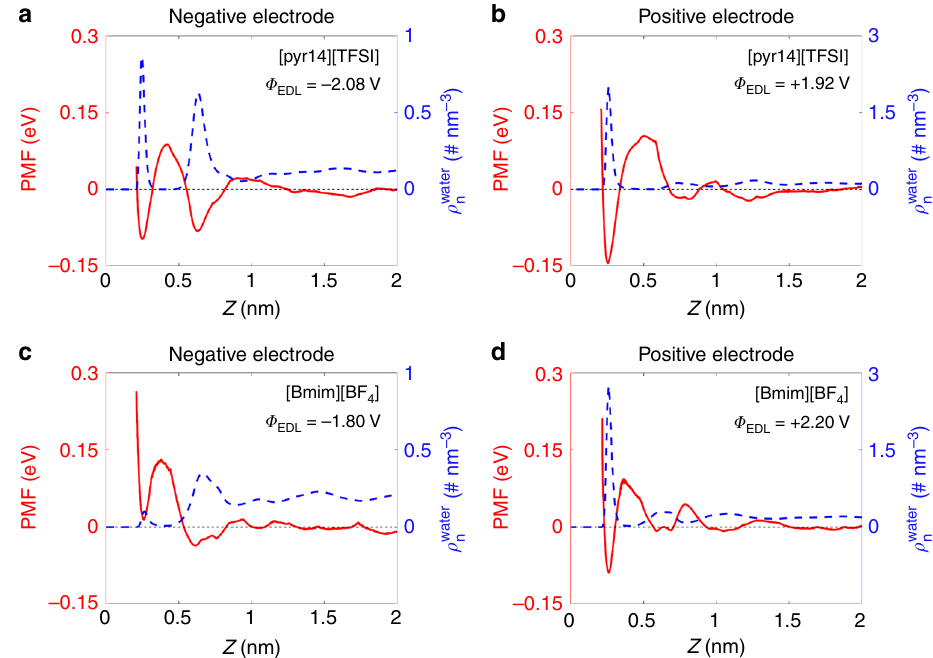
Fig. 4 The propensity for water electrosorption at gold electrodes. a – d Correlation between the distributions of water density (dashed blue lines, right blue y -axis) and the potential of mean force (PMF) for water (solid red lines, left red y -axis) for room temperature ionic liquids at gold electrodes: in 1-butyl-1- methylpyrrolidinium bis(tri fl uoromethylsulfonyl)imide ([pyr14][TFSI]) at a negative and b positive electrodes, and in 1-butyl-3-methylimidazolium tetra fl uoroborate ([BMIM][BF 4 ]) near c negative and d positive electrodes. The applied potential between the two electrodes is 4 V, and the PMF curves are obtained by umbrella sampling along the distance from the electrode surface. The electrical double layer potential ( Φ EDL ) at negative or positive electrode is labeled in each